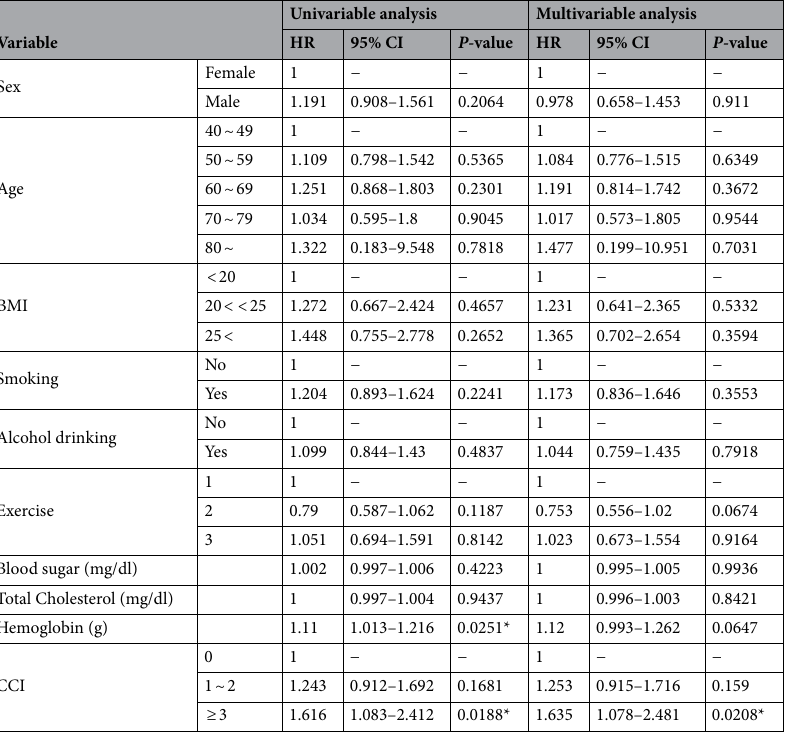
Table 4. Univariate and multivariate logistic regression analyses of factors influencing reoperation. HR, hazard ratio; CI, confidence interval, PELD, Percutaneous endoscopic lumbar discectomy; BMI, Body mass index; CCI, Charlson comorbidity index. * Statistically